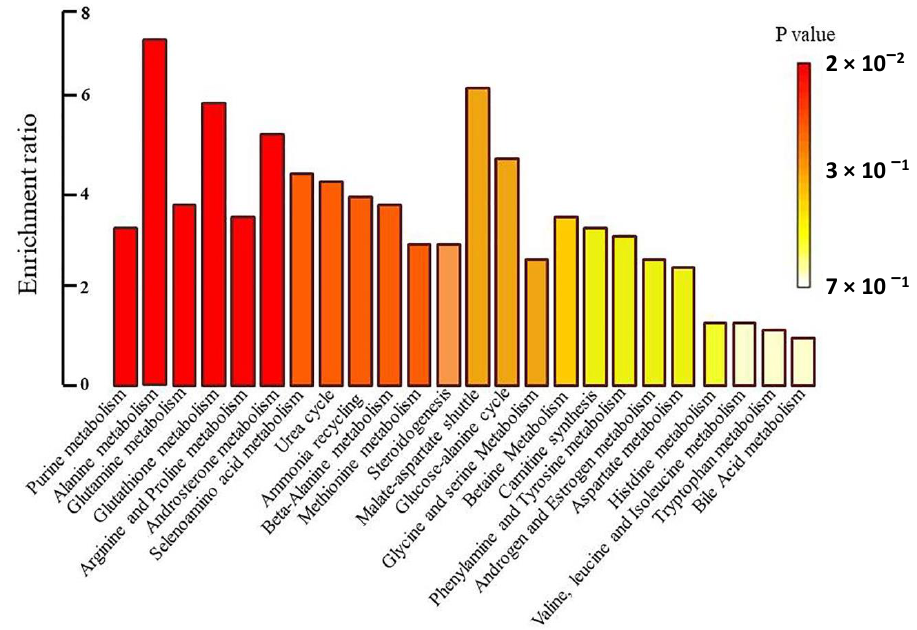
Figure 5. Metabolite set enrichment